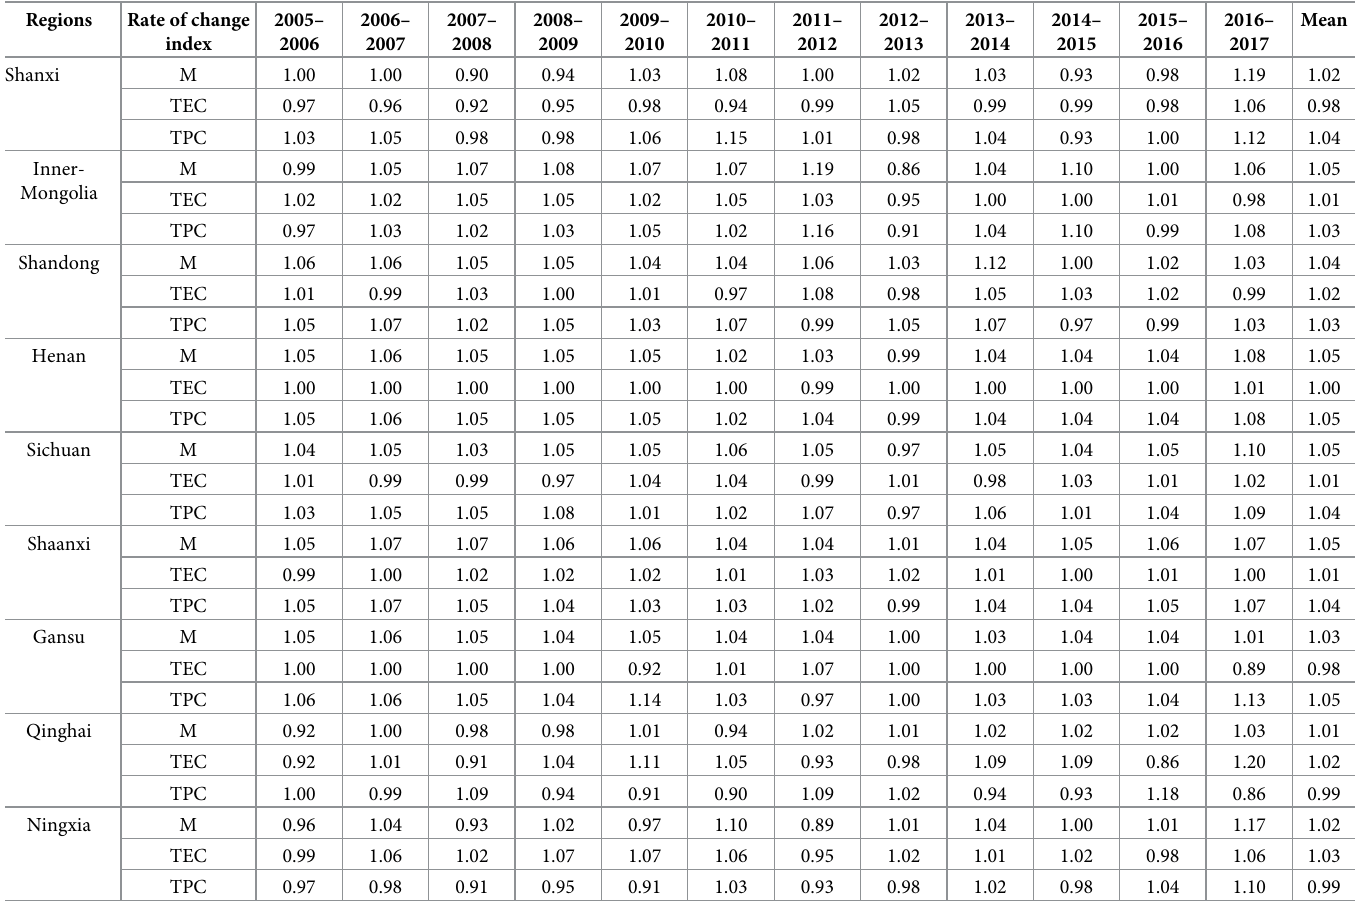
Table 5. Results and decomposition of Malmquist